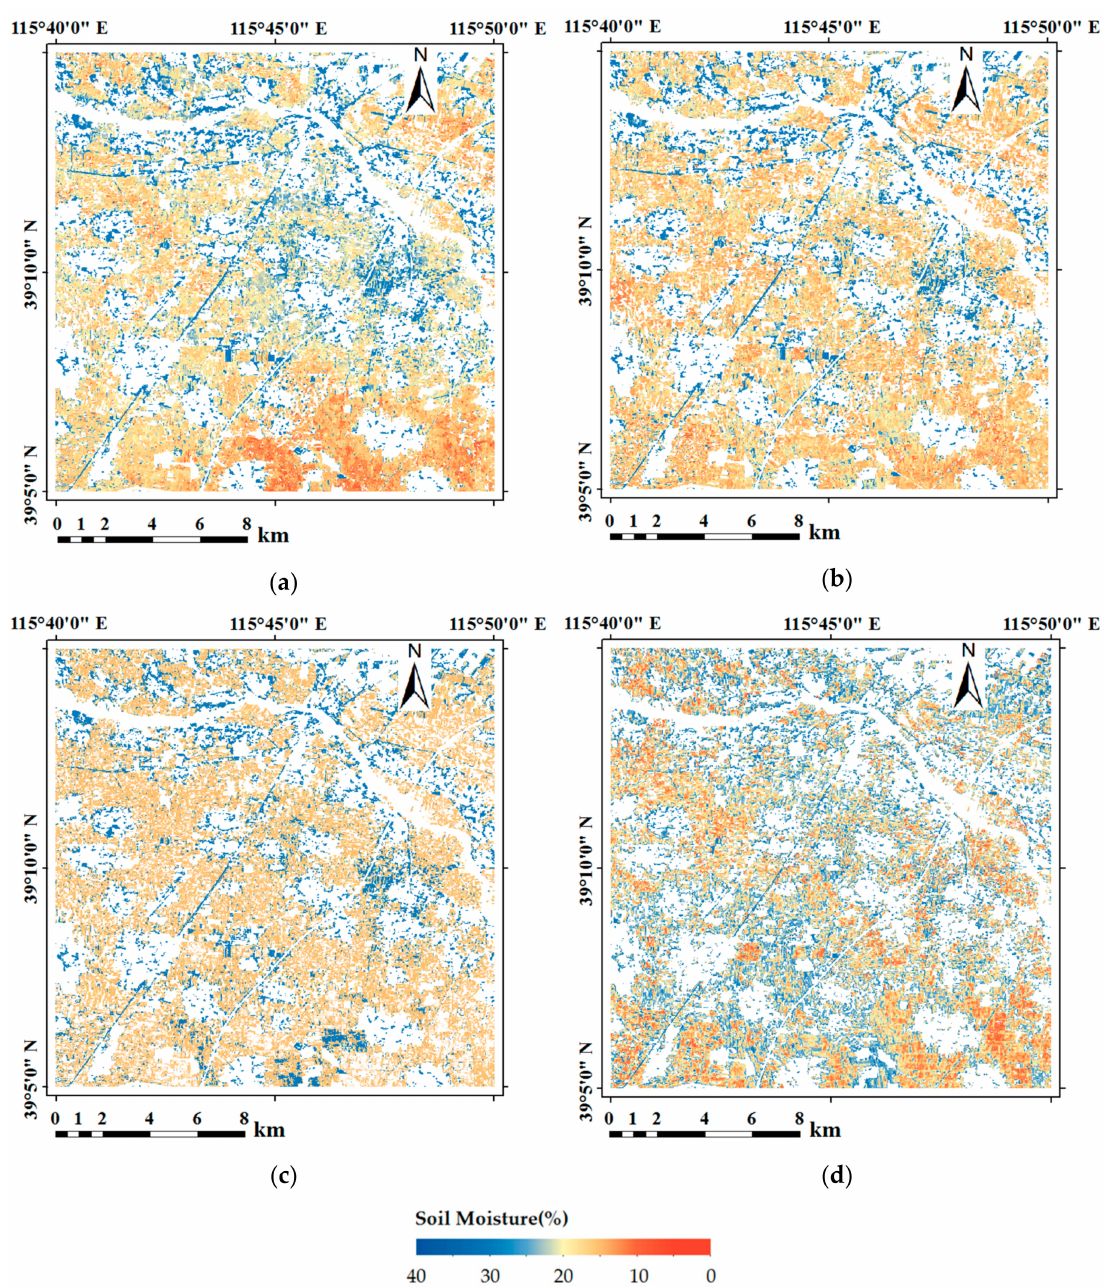
Figure 9. Spatial distribution maps of soil moisture in each period of the study site: ( a ) 21.3.2013; ( b ) 14.4.2013; ( c ) 15.5.2013; ( d )